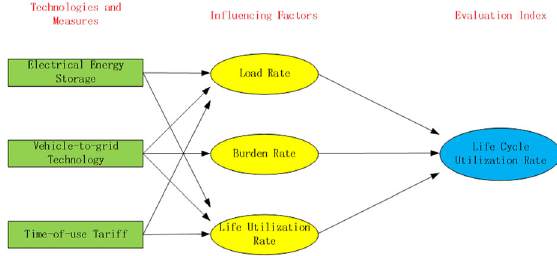
Fig. 1 The relationship of the evaluation indexes with the intelligent power consumption technologies and